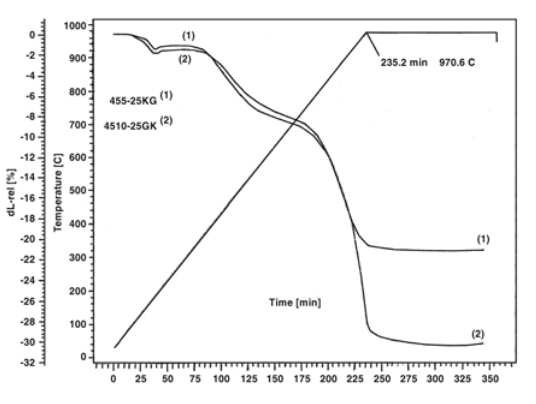
FIGURE 4 Dilatometer analysis of #455 (95:5) and #4510 (90:10) Ag = Pd